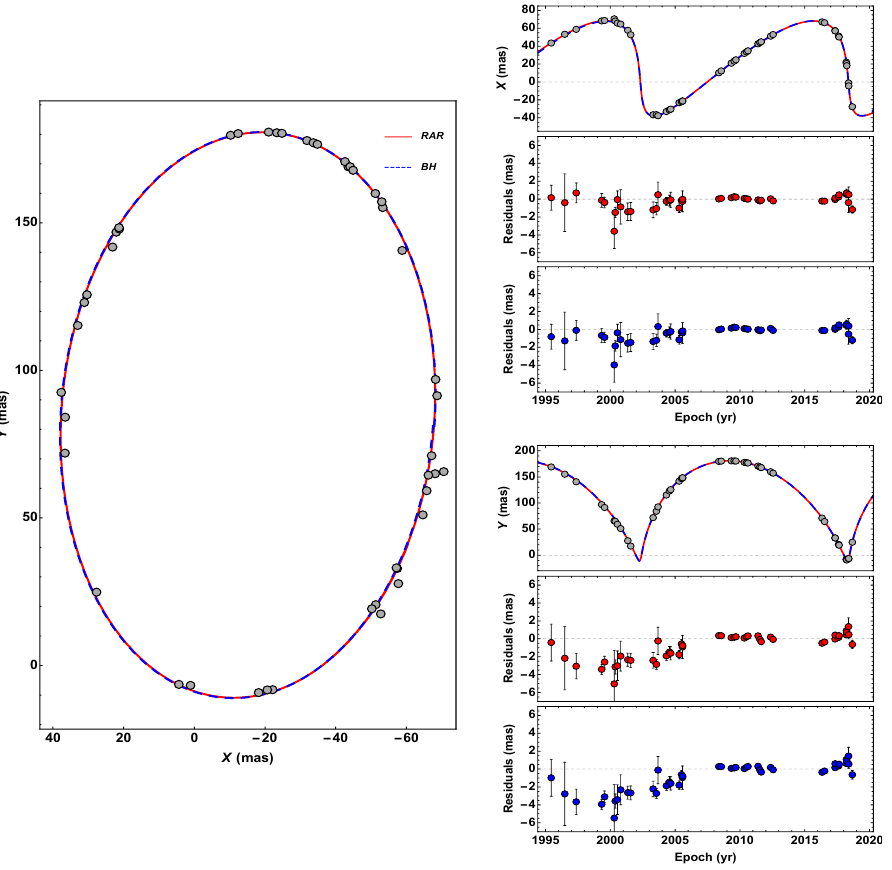
Figure 3. Theoretical (central BH and RAR models) and observed orbit of S2 around Sgr A*. The left panel shows the orbit, i.e., the right ascension ( X ) vs. declination ( Y ), while the right panel shows X and Y vs. observation time, with the residuals of the best fit for the BH ( blue ) and the RAR ( red ) models. The theoretical models are calculated by solving the equations of motion (see Appendix A) of a test particle in the gravitational field of (1) a Schwarzschild BH of 4.075 × 10 6 M (cid:12) , and (2) the DM-RAR model for 56 keV fermions (leading to a quantum core mass 3.5 × 10 6 M (cid:12) ). Reproduced from [34] with permission from Astronomy & Astrophysics, Copyright